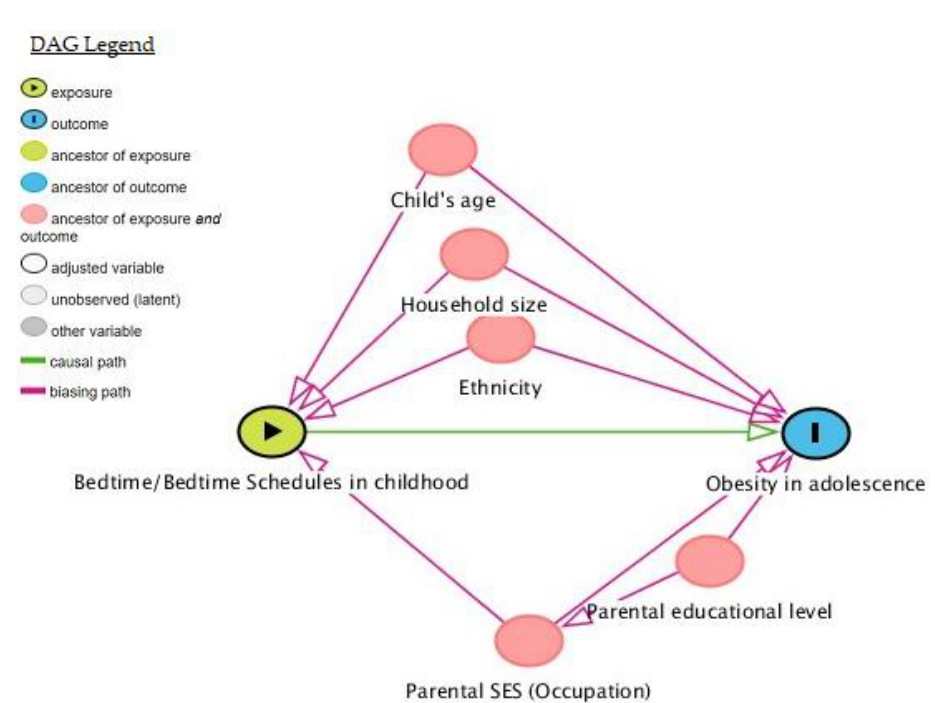
Figure 2. Directed acyclic graph (DAG) for the relationship between bedtime in childhood and obe- sity risk in adolescence showing all considered covariates. DAG legend is shown on the top left- hand corner.